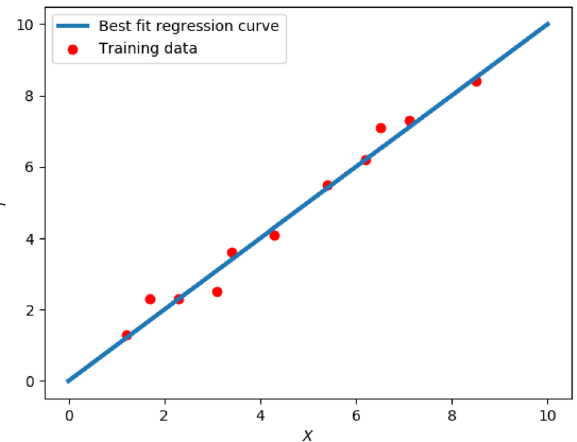
Figure 1. Linear regression. Red dots represent the training data for regression, and blue line represents the best fit for the given training